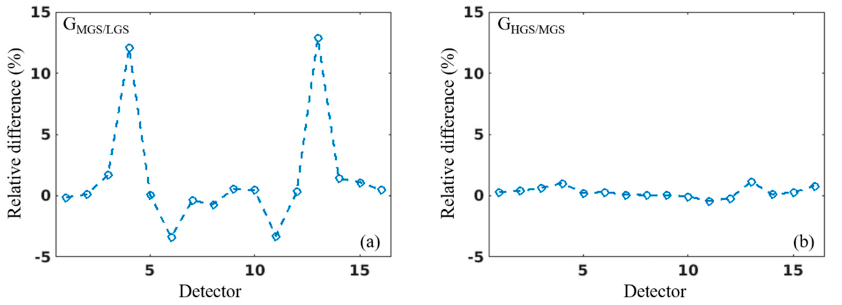
Figure 8. ( a ) Relative difference between G MGS/LGS determined by linear regression method and the original method. ( b ) Relative difference between G HGS/MGS determined by linear regression method and the original method. Difference = 100% × (linear regression − original)/original. NOAA-20 VROP data were collected on October 8, 2018, for aggregation mode 21.